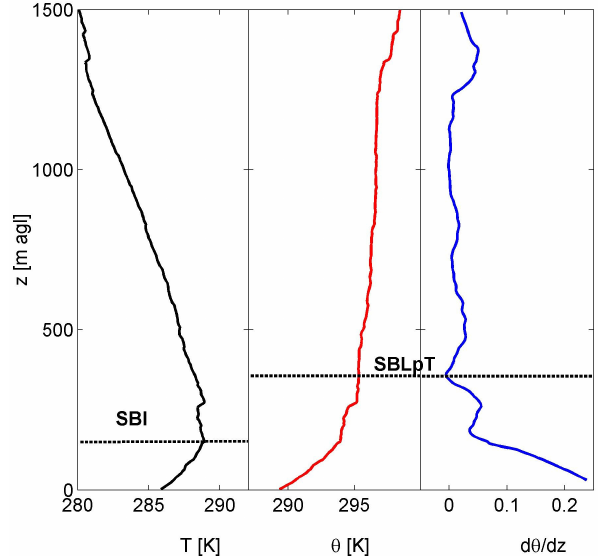
Figure 3. Detection of the SBL from RS T profile of 17/07/2012: (a) the surface-based temperature inversion (SBI) determined by the first T decrease as a function of altitude, (b) the top of the stable layer (SBLpT) detected by the stability of θ profile or by the van- ishing T